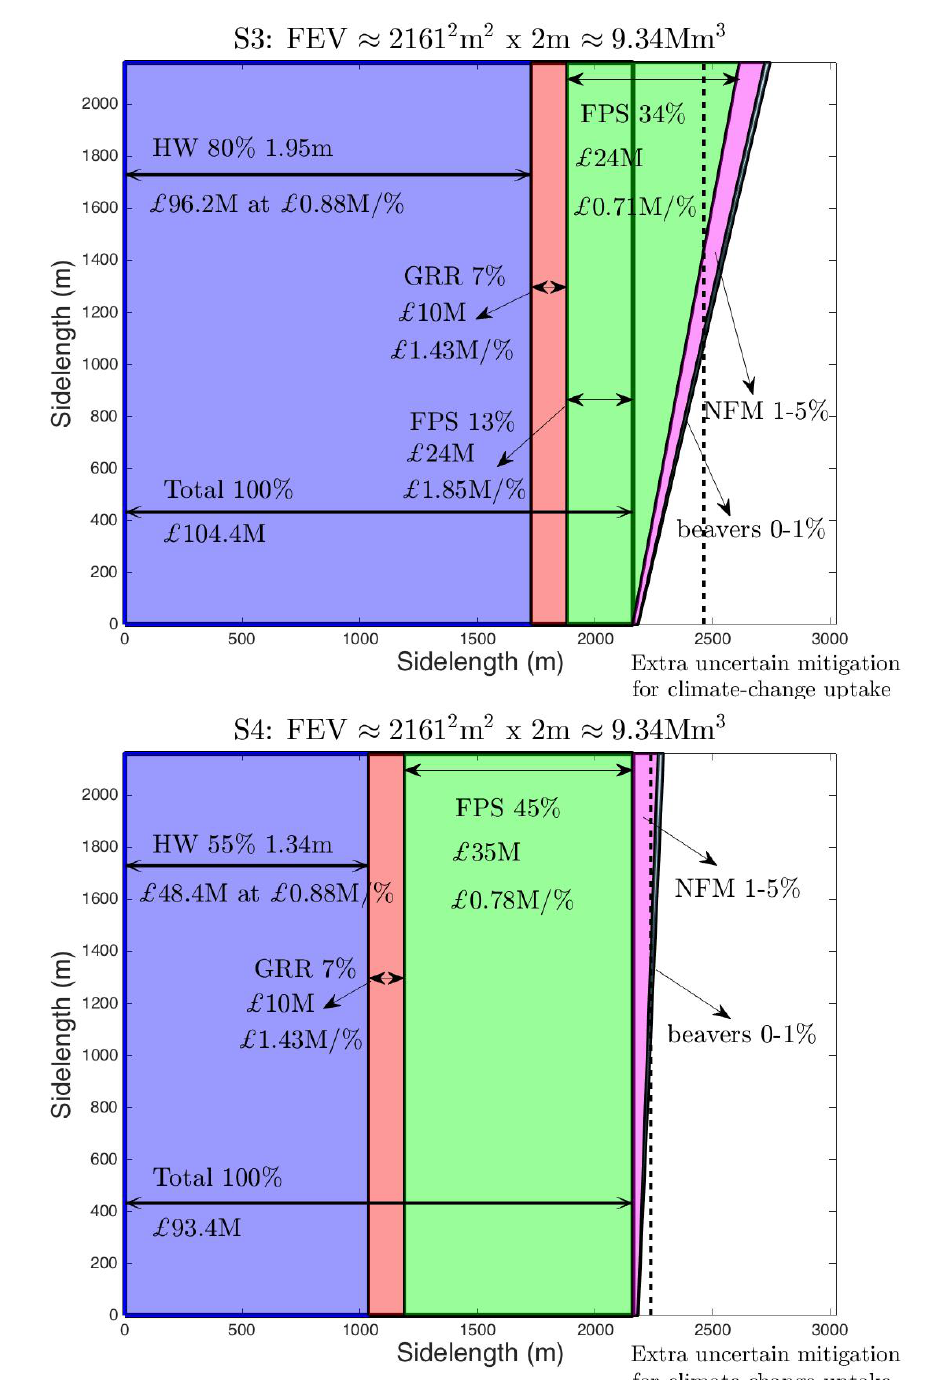
Figure 10. Scenarios S1 to S4 with contribution of each flood-mitigation measure proportional to the length of the (inverted) double-headed arrows. Contributions to the square flood-excess lake (of the same capacity as the FEV) are: higher walls with wall-heights indicated (HW—mauve); river-bed widening (GRR—red); and (enhanced) flood-plain storage (FPS—green). The uncertain, slanted parts of FPS, natural flood management (NFM—pink) and beaver colonies (small sliver—blue) are used as extra flood mitigation to offset climate-change effects, beyond the 2161 m side, with the mean denoted as the vertical dashed line. Above or alongside the double arrow the total percentage of protection for each flood-mitigation measure is given; below the double arrow costs and relative cost per 1% of flood mitigation are stated. Total costs are indicated under the double arrow spanning the lake